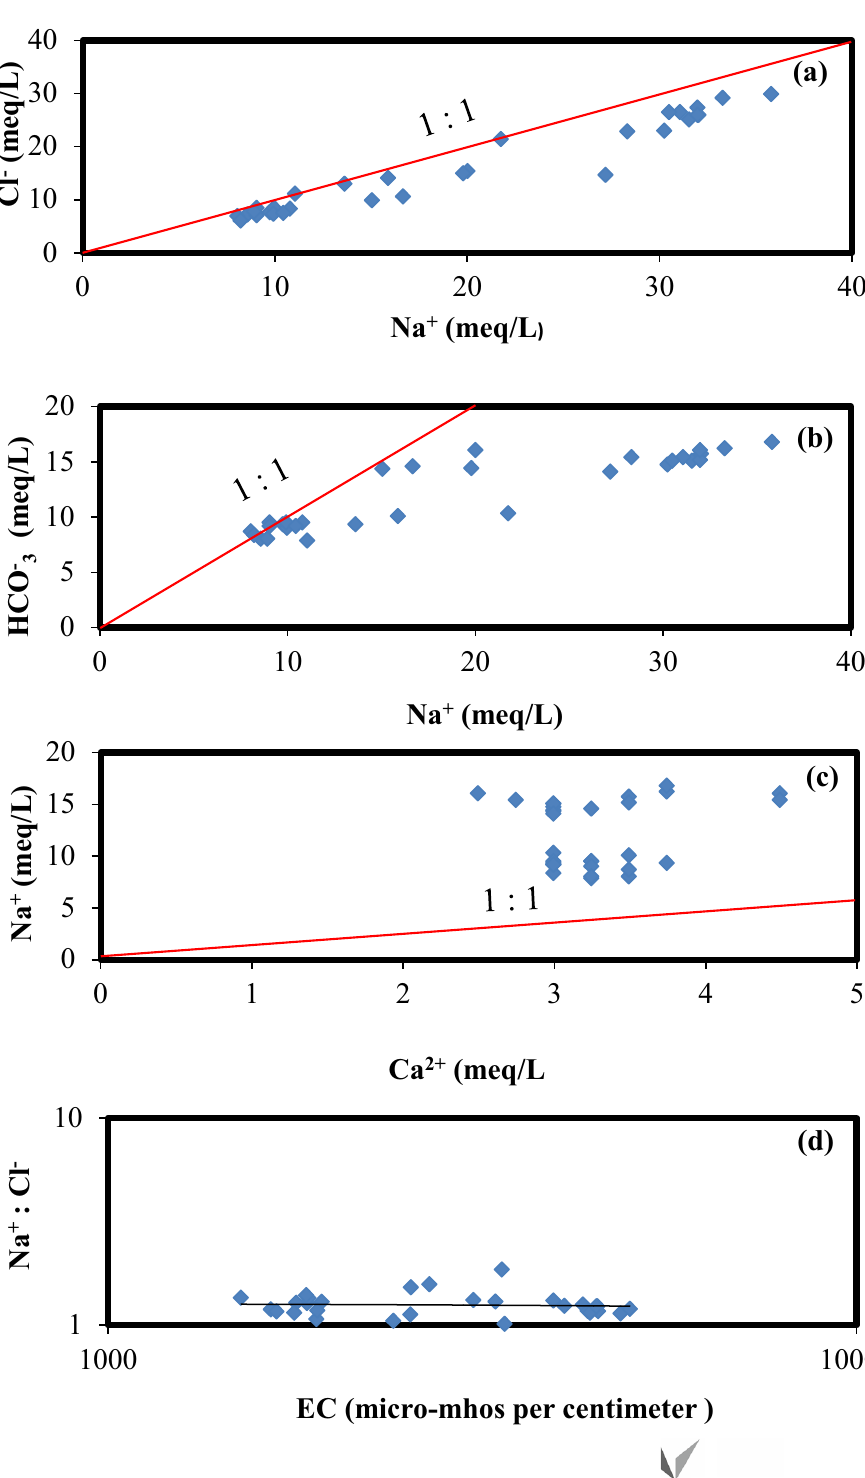
Fig. 6 Relation between a Na + and Cl − , b Na + and Na + and Ca 2+ and d EC and Na + : Cl